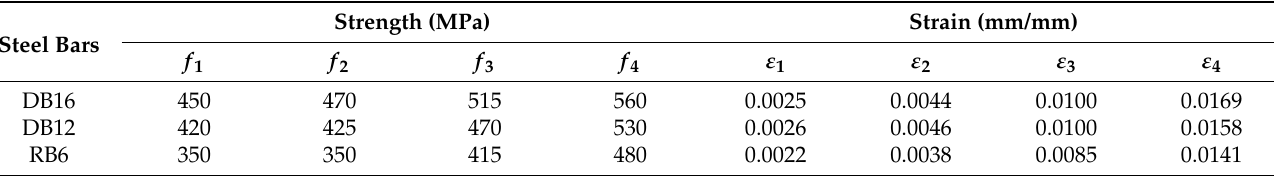
Table 3. Mechanical properties of steel